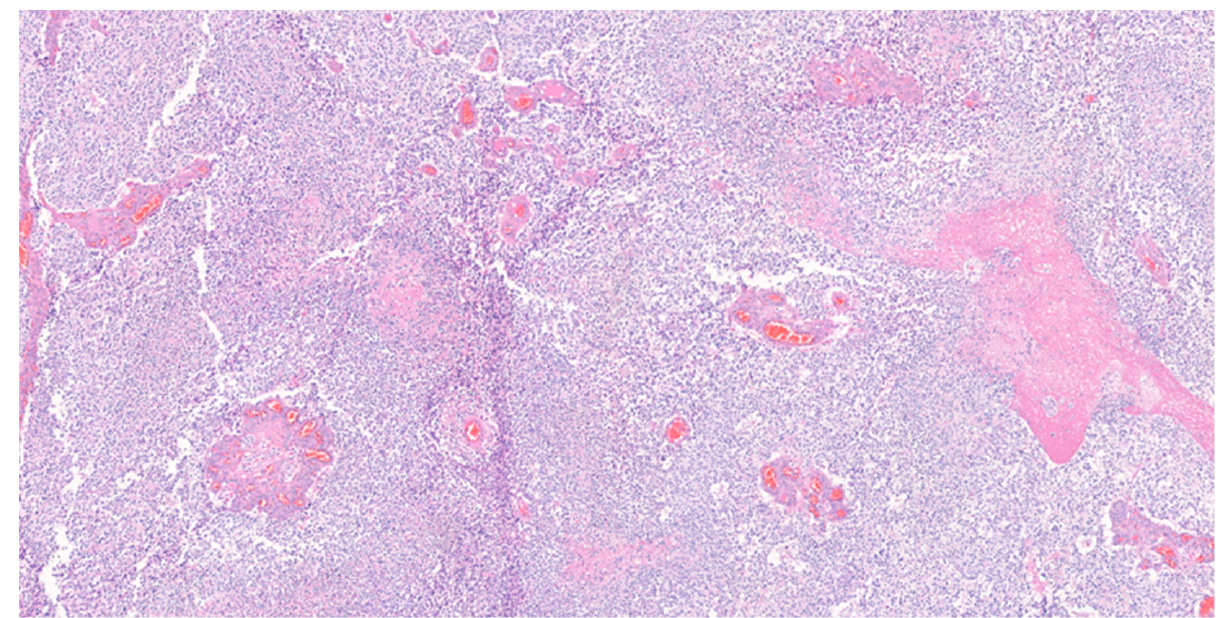
Figure 3. Computed tomography angiography . Imaging revealed focal heterogeneous enhancement with a surrounding multilinear contrast structure, and a lower density and calcified spots in the right temporal-parietal occipital lobe. The green arrow shows an ipsilateral supraclinoid internal carotid artery aneurysm.